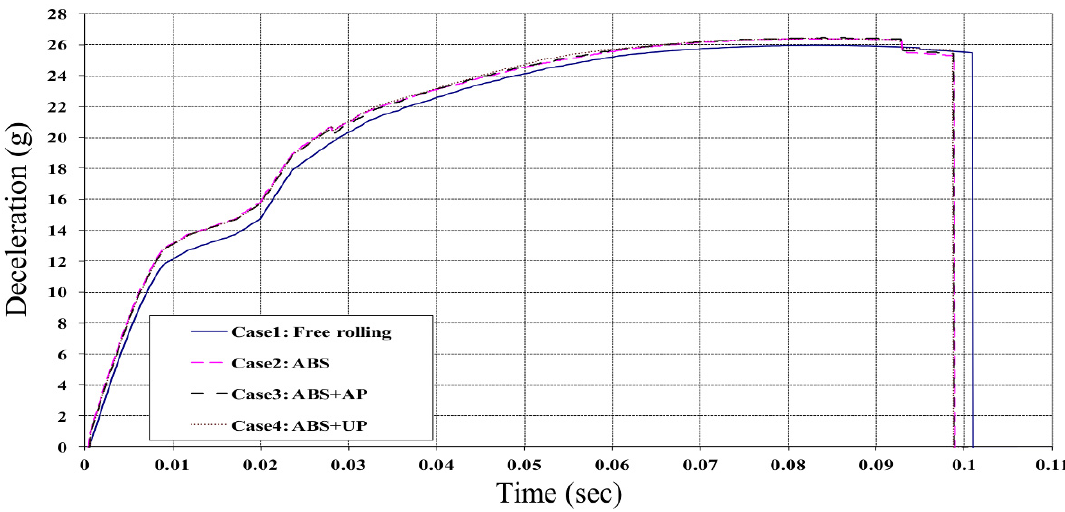
Figure 18. Deceleration of the vehicle body for all cases at offset collision and speed of 70 km/hr.